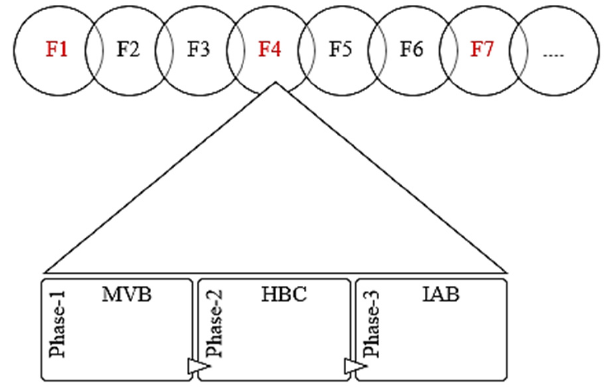
Figure 2. Interleaved Honeypot Frame.